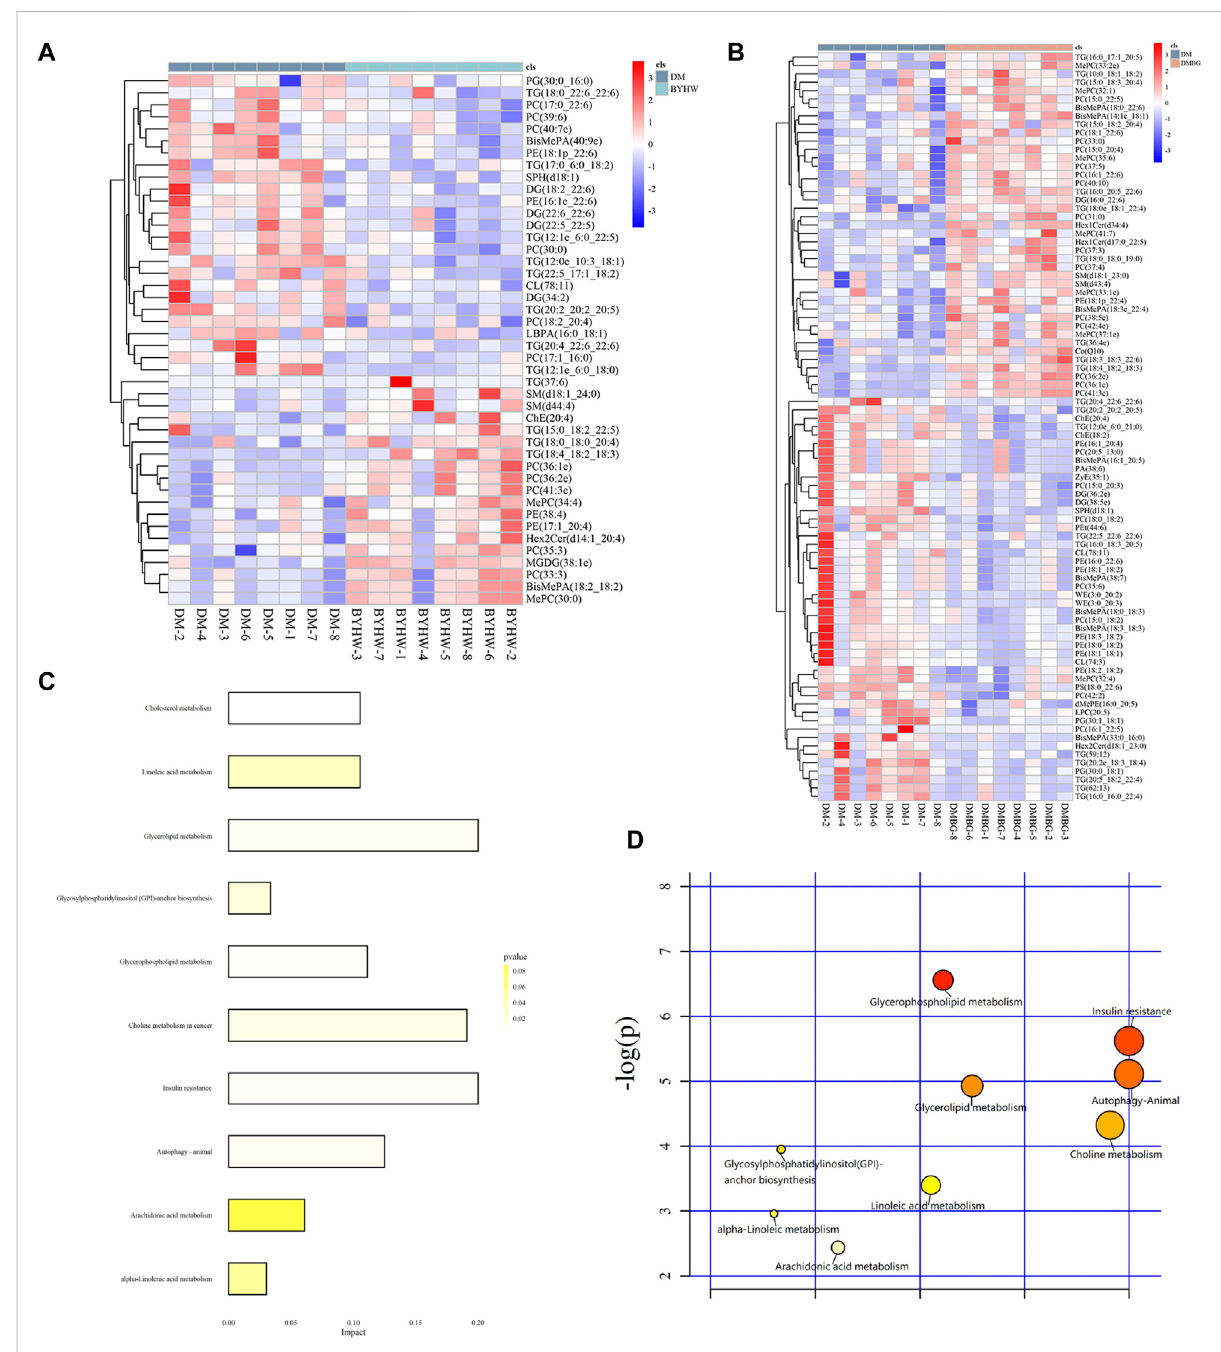
FIGURE 10 BYHWD affected the lipid classi fi cation identi fi ed by the hierarchical cluster analysis: (A) lipid classi fi cation identi fi ed by LC-Orbitrap MS; (B) hierarchicalclusteranalysisbetweenthecontrolandDMgroups;control-1tocontrol-6representtheliversamplesofsixratsfromthecontrolgroup, andDM-1toDM-8representtheliversamplesofeightratsfromtheDMgroup; (C) hierarchicalclusteranalysisamongthefourstudygroups.BYHW- 1 to BYHW-8 represent the liver samples of eight rats from the DM + BYHWD group, and DMBG-1 to DMBG-8 represent the liver samples of eight rats from the DM + DMBG